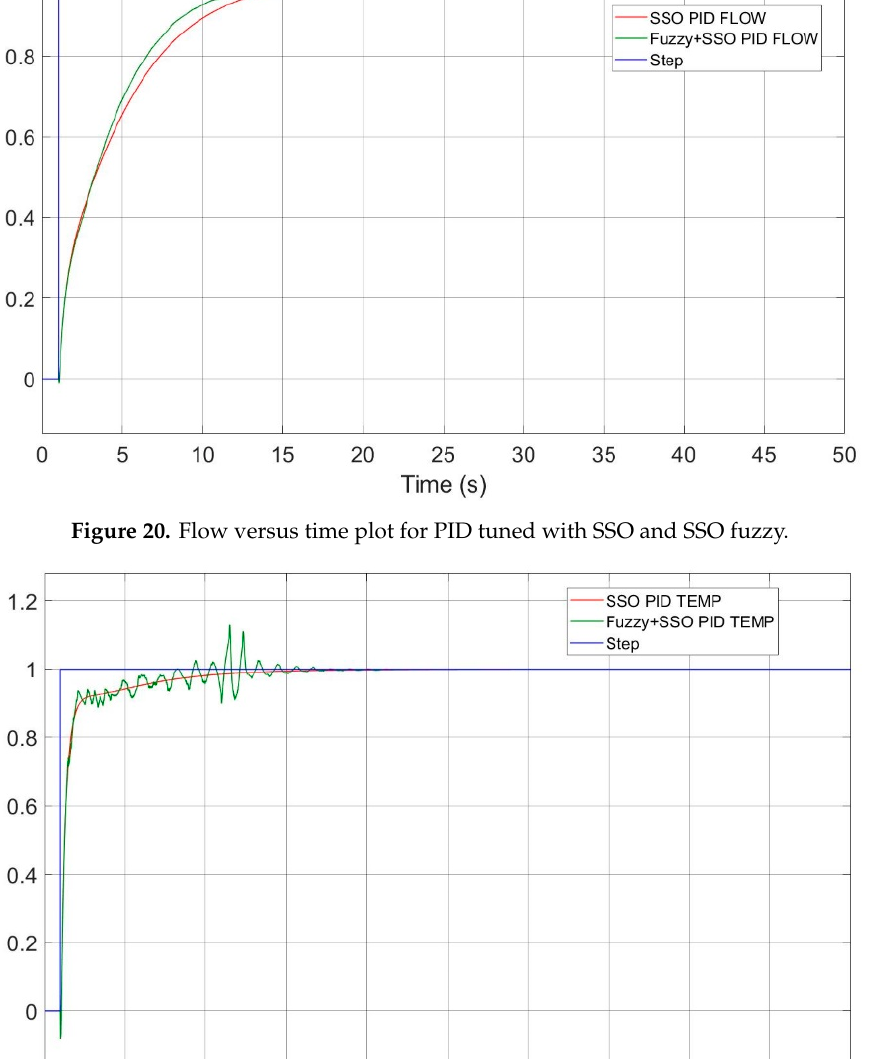
Figure 19. Temperature versus time plot for PID tuned with PSO and SSO.